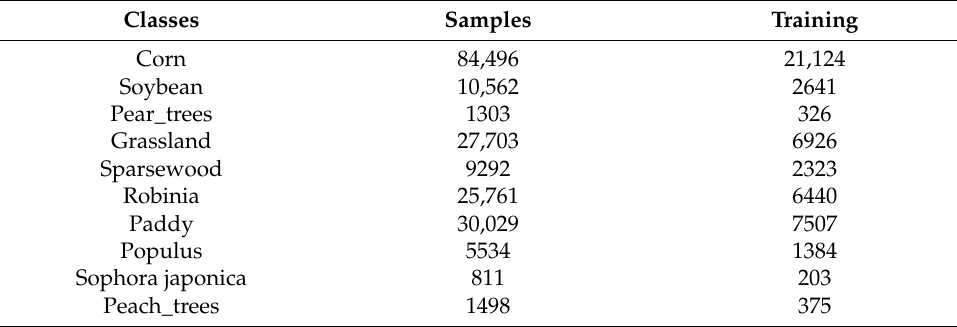
Table 4. Samples and training samples used for the Xiong’an dataset.